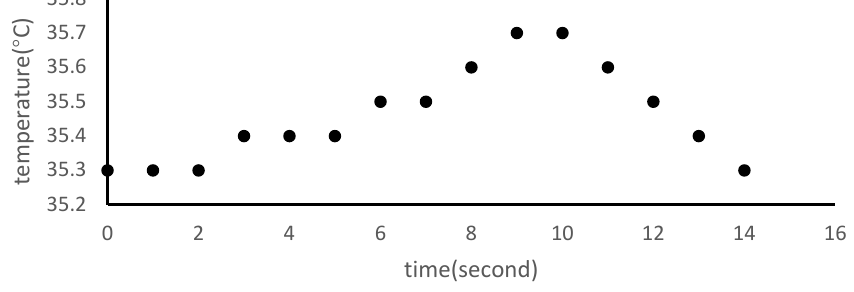
Figure 9. Temperature change during the Er:YAG ‐ PLD procedure.